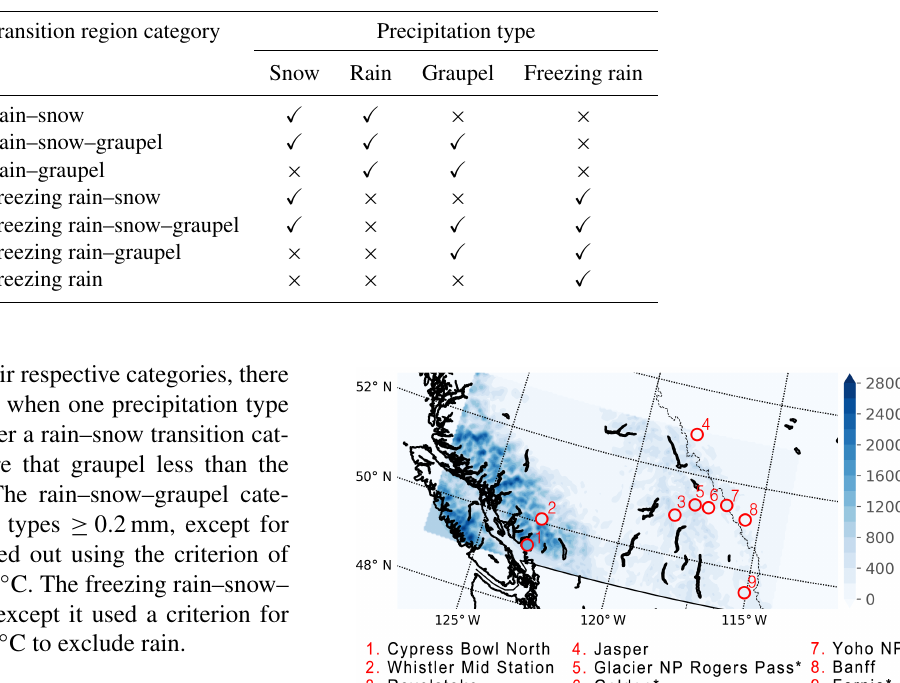
Table 1. Transition region categories and their associated precipitation types. Check marks indicate when the ≥ 0 . 2mm criterion was satis- fied. A wet-bulb temperature criterion ≤ 0 ◦ C was used to exclude rain, whereas a criterion > 0 ◦ C was used to exclude freezing rain.